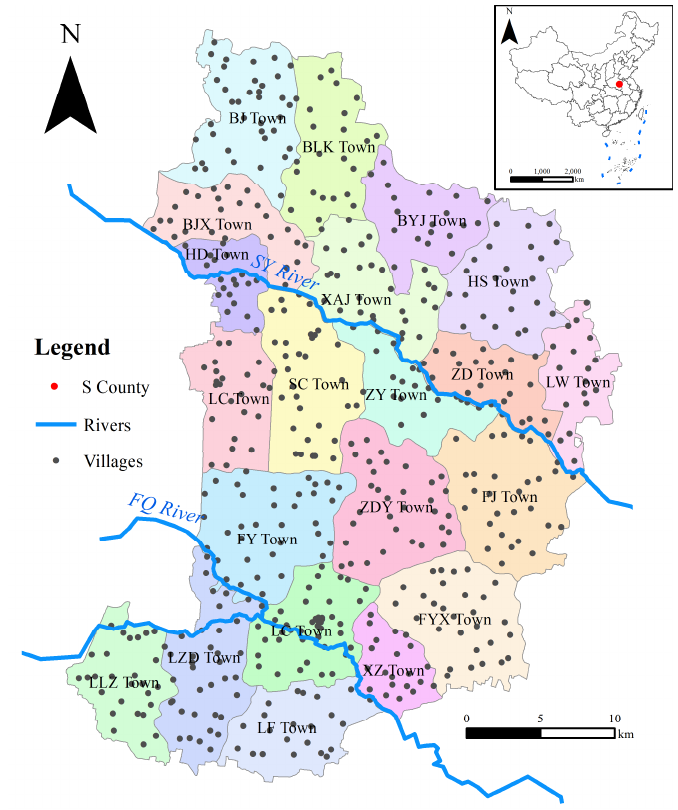
Figure 1. Illustration of S County.